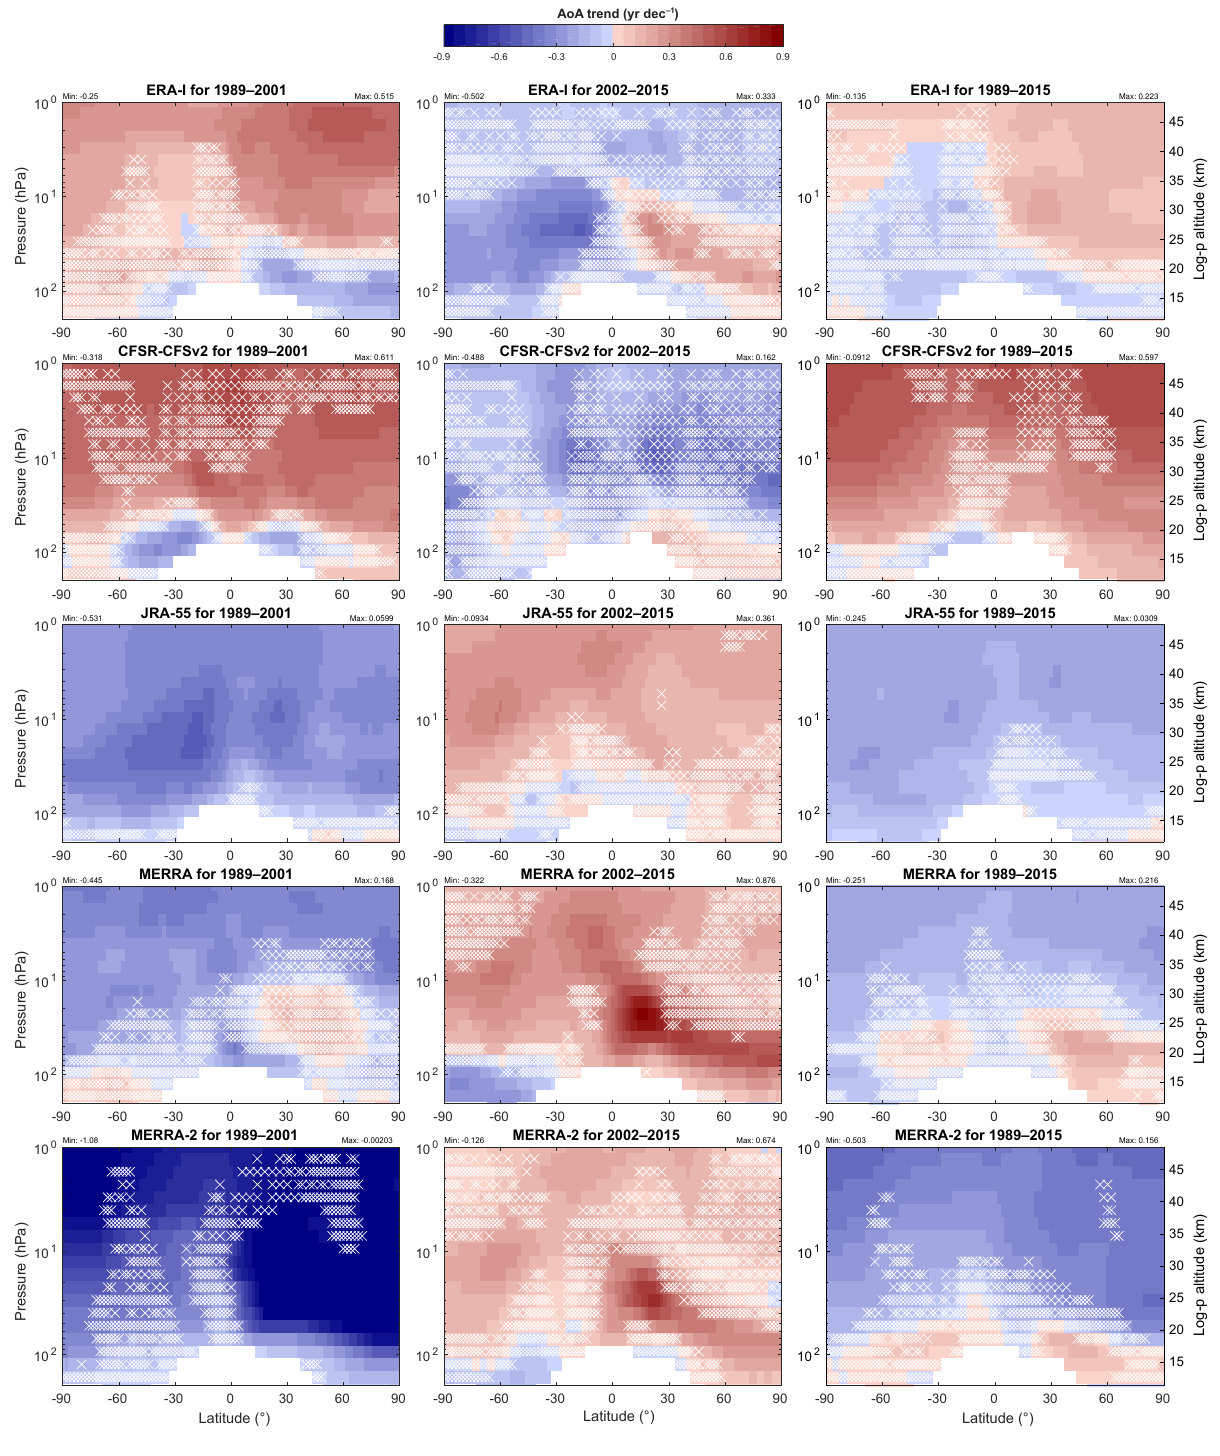
Figure 12. Latitude–pressure distributions of AoA trends (in years per decade) over 1989–2001 (left column), 2002–2015 (middle column) and 1989–2015 (right column) using the five reanalyses (from top to bottom: ERA-I, CFSR, JRA-55, MERRA, MERRA-2). White crosses and colors have the same meaning as in the previous figure, but note the different scale (top of figure).